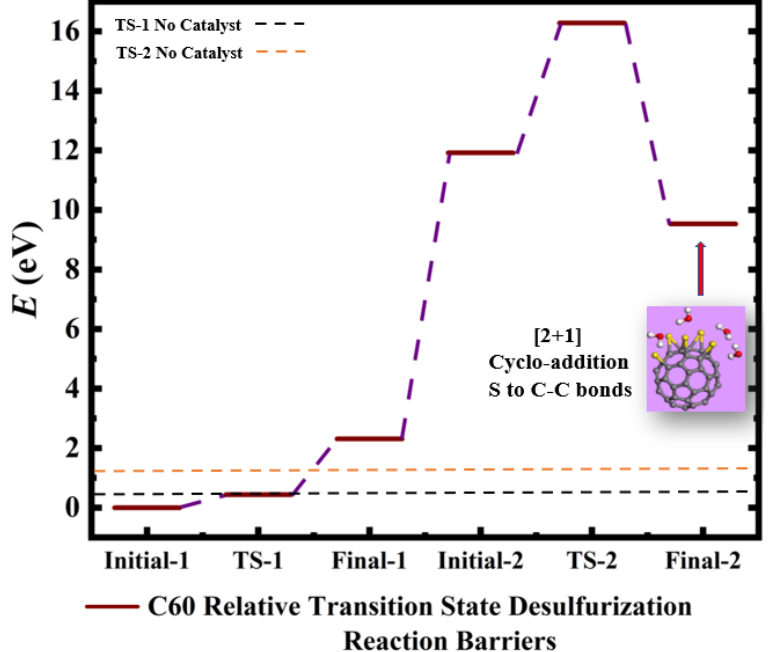
Figure 6. Calculated relative initial, transition, and final states reaction barriers of step 1 and step 2 for the oxidation–reduction of sulfur dioxide to elemental sulfur (S) by utilizing doubly-charged negative fullerene C-60 represented by the brown bars. Light purple inset: geometrically optimized final state 2 (Final-2) of the C-60 catalyst with [2+1] cycloaddition elemental S to fullerene C-C bonds and 4 molar H 2 O as the final product for step 2. Sulfur, carbon, oxygen, and hydrogen are represented by the yellow, gray, red, and white spheres, respectively .